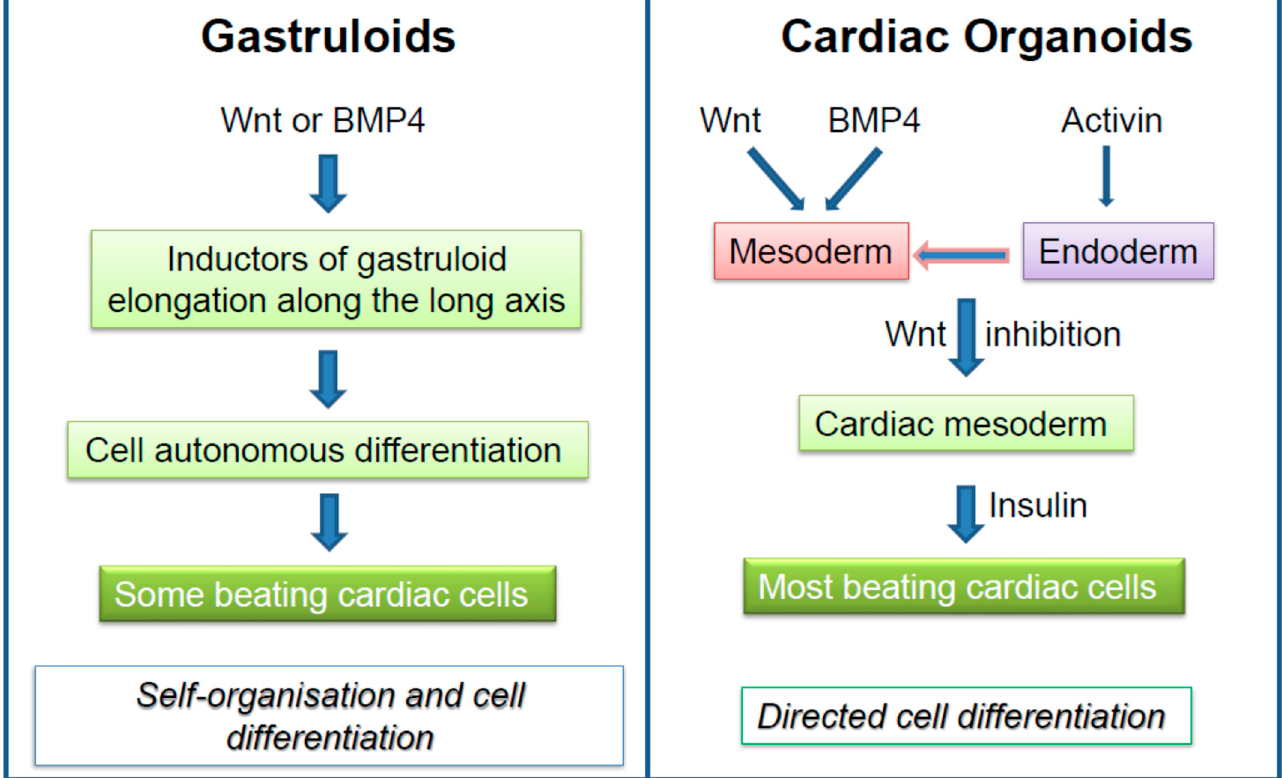
Figure 3. Comparative morphogens and signaling pathways involved in the generation of cardiomyocytes in gastruloids versus cardiac organoids.